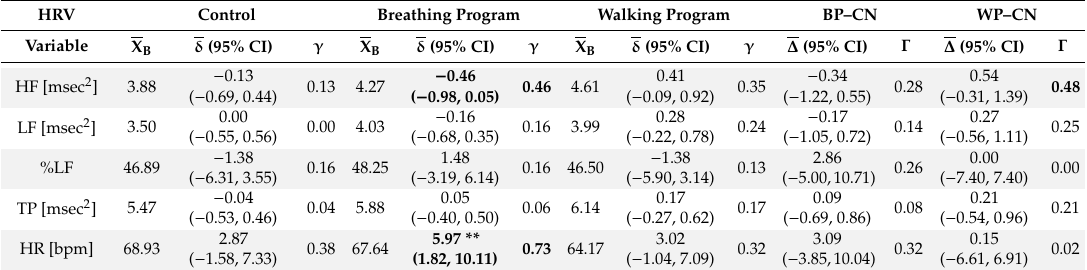
Table 5. Changes in HRV variables after FTPs (ANCOVA results). The details are identical to those in Table 3. HF, high frequency; LF, low frequency; TP, total power; HR, heart rate. HRV Walking Program